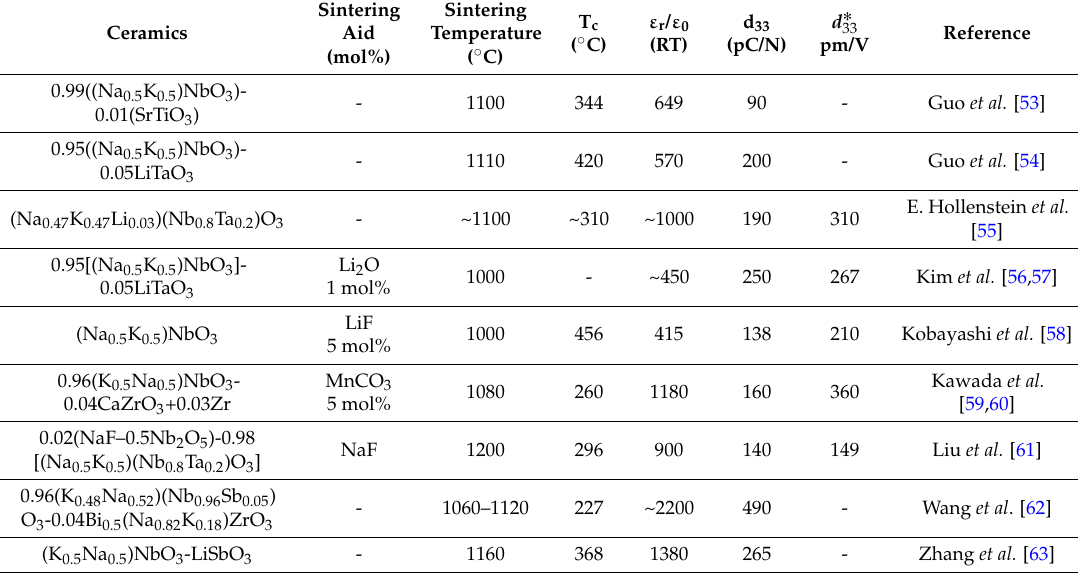
Table 3. Properties, additives, and sintering temperatures of several NKN-based piezoelectric ceramics. Sintering Ceramics